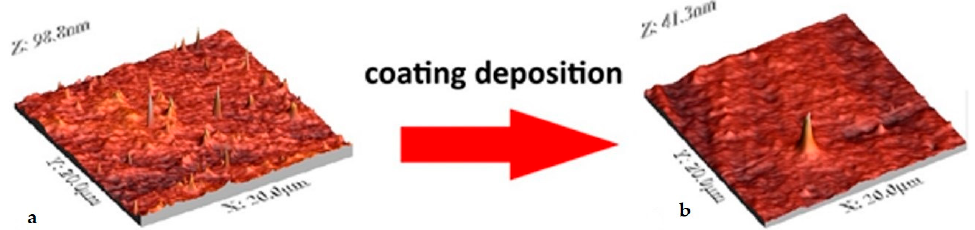
Figure 6. AFM images of poly(ethylene terephthalate) before ( a ) and after ( b ) SiO 2 /TiO 2 4-layered coating deposition.